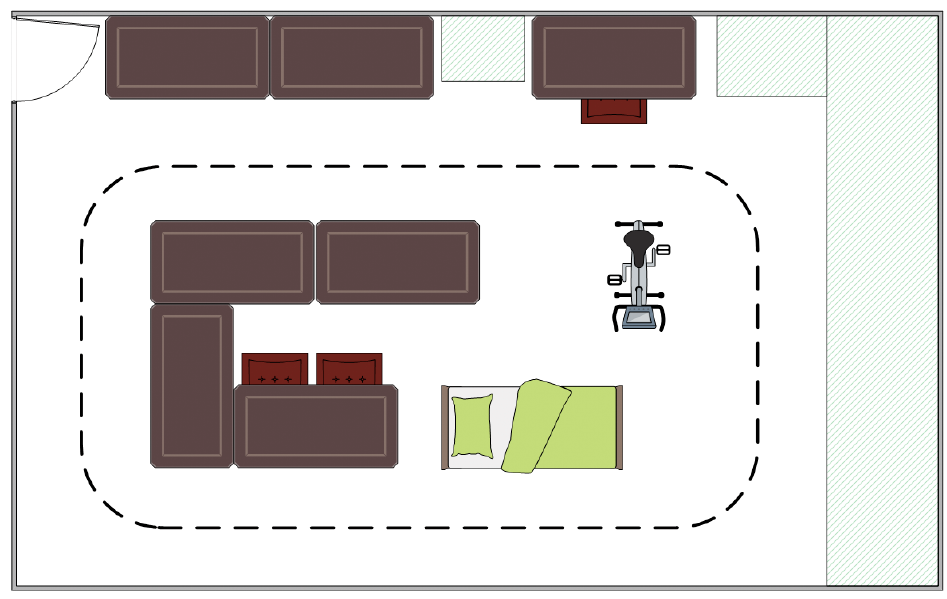
Figure 3. Sketch of the experimental floorplan (not to scale). The dotted line represents the walking and running course. The illustrated bed was a treatment table, the chairs in the middle allowed participants to sit down, and the home trainer allowed for cycling activities.